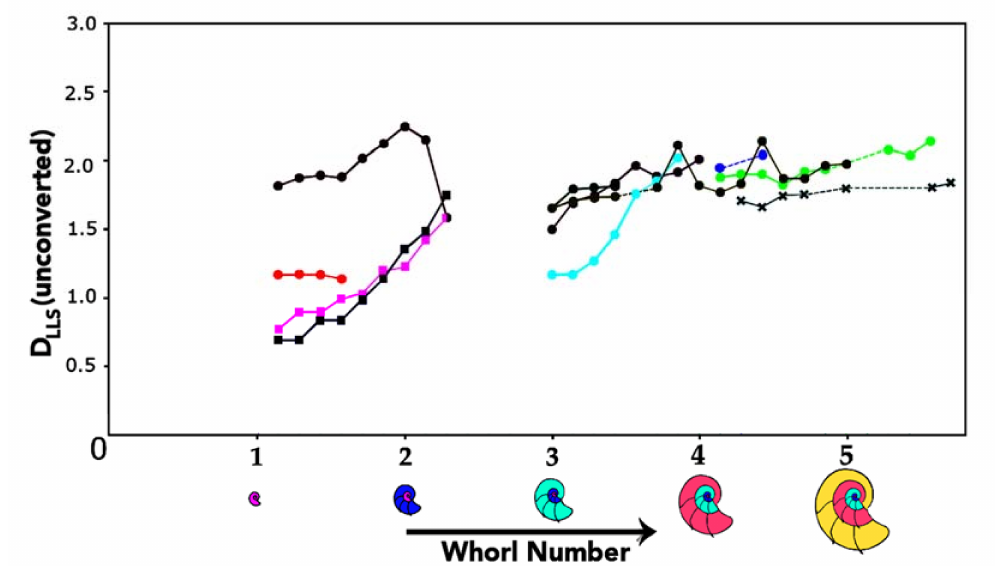
Figure 8. Plotted ontogenetic complexity of ammonite sutures using unconverted LLS data using [44]. Each symbol is for one suture and each curve is for sutures from a single shell. The y -axis shows the unconverted LLS fractal dimension. Squares indicate perisphinctids, circles indicate lytoceratids, and x-shaped points indicate